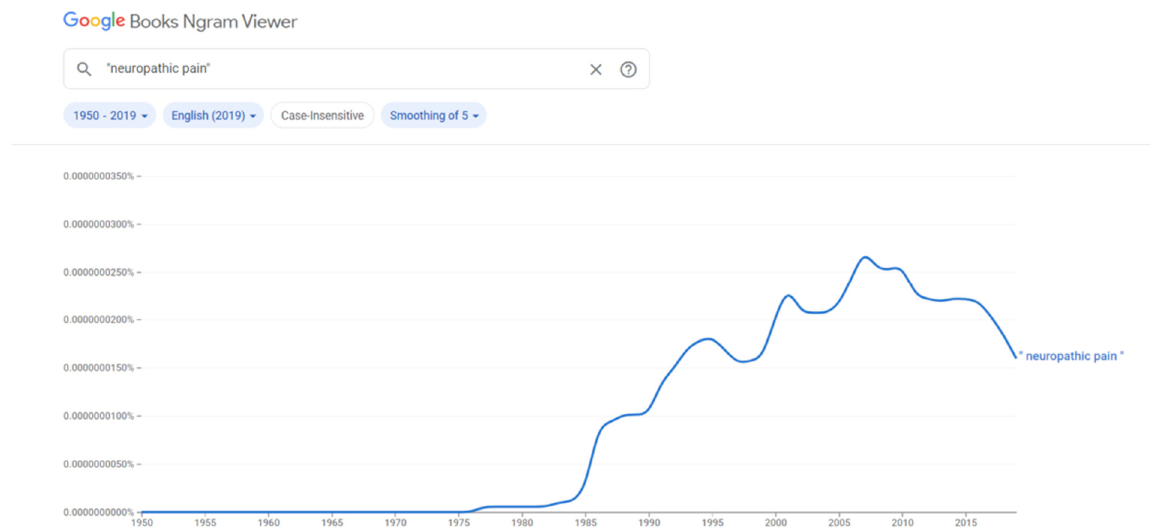
Figure 1. Presence of the term “neuropathic pain” in the books archived in Google. An increase is visible from the 1980s. In the x -axis the years are presented, in the y -axis the relative frequency of the terms in the digital sources.